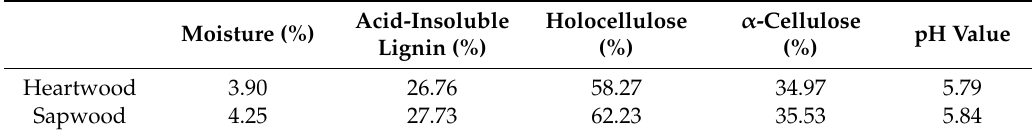
Table 2. Chemical components of woods.